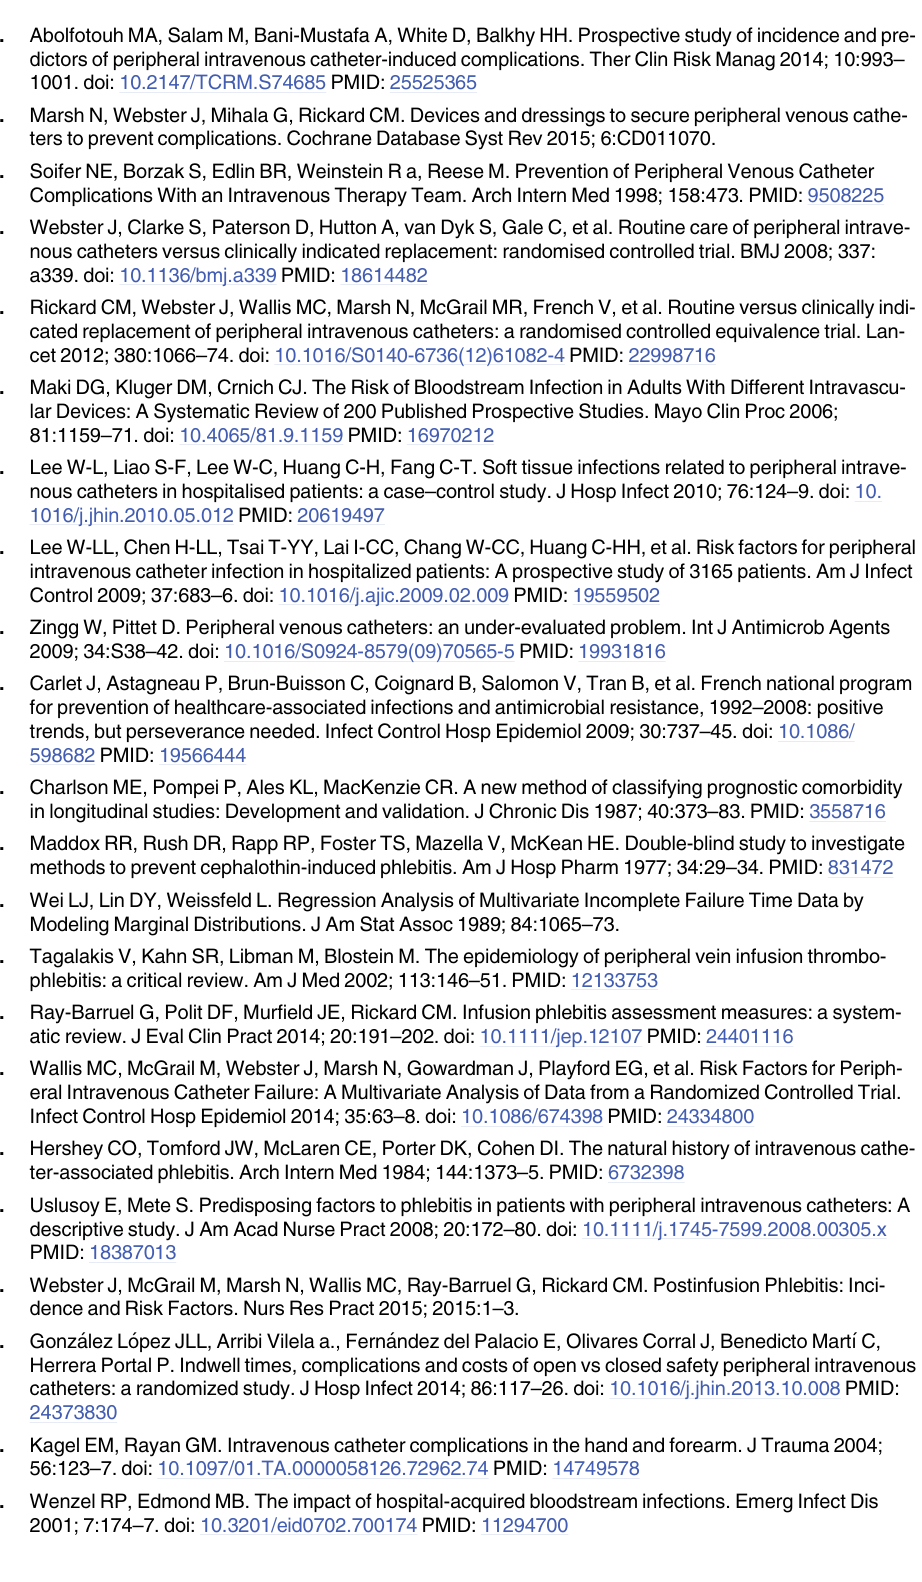
PLOS ONE | DOI:10.1371/journal.pone.0168637 January3,